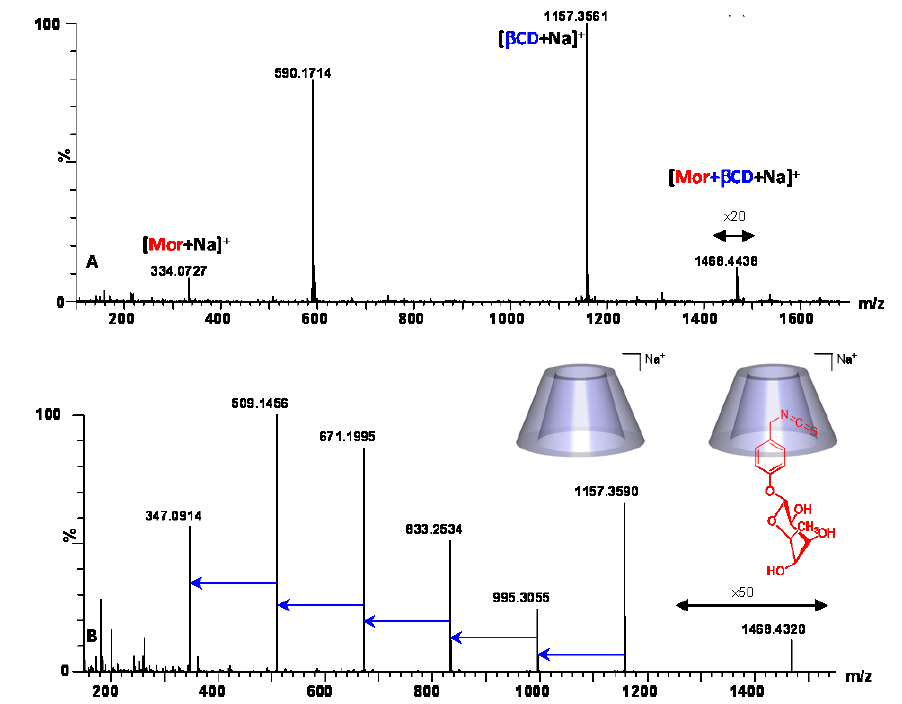
Figure 13. MS ( A ) and MS/MS ( B ) of equimolar mixture of β -CD/MOR in water (0.5 mM) recorded in ESI + . The MS/MS spectrum ( B ) was obtained at a collision energy of 95 eV, as applied for α -CD/MOR study (Figure 12B).